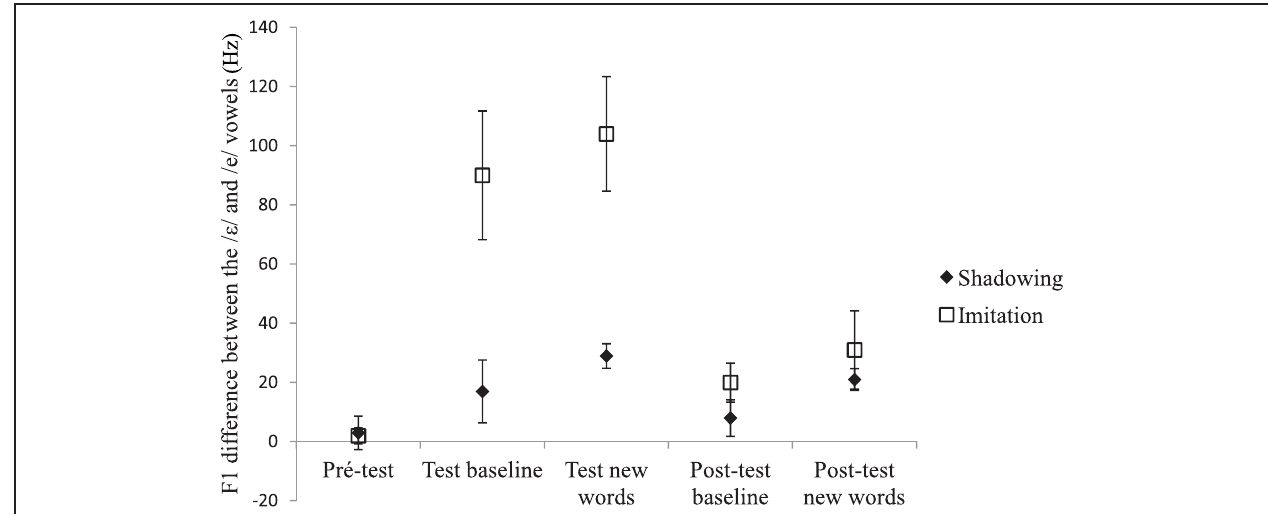
FIGURE 4 | Average difference in F 1 frequency (Hz) between the / ε / and /e/ vowels and standard errors for each phase. The label baseline words refers to the words used in the pre-test, and the label new words refers to the words that were used in the test and post-test